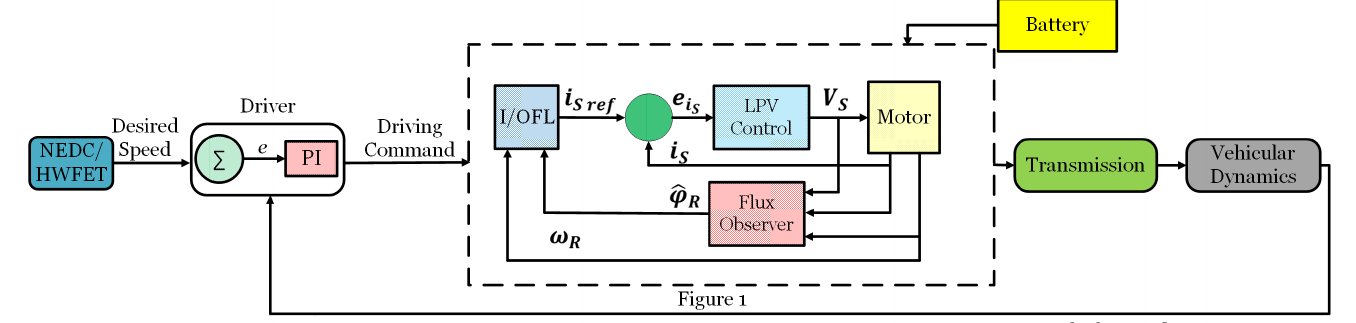
Figure 3. Electric vehicle control